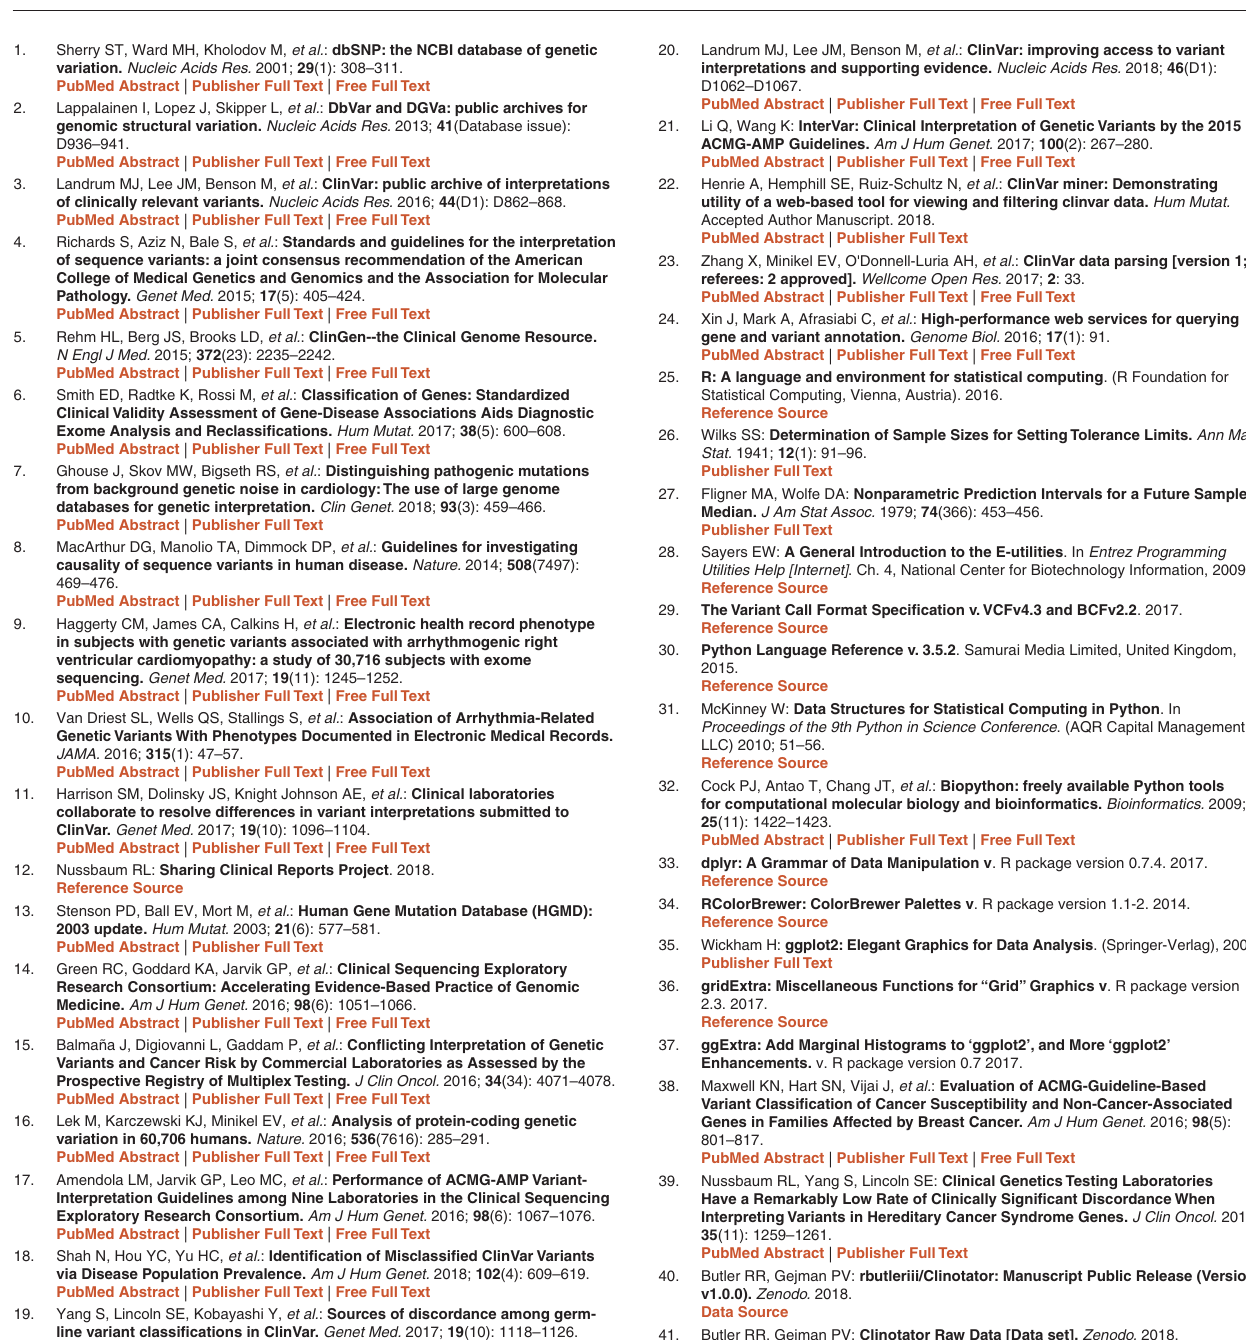
Supplementary Table 2. ClinVar conflicting interpretation variants of high priority for reclassification. A table of the output annotations for ClinVar ‘conflicting interpretation of pathogenicity’ variants with a Clinotator reclassification recommendation score of